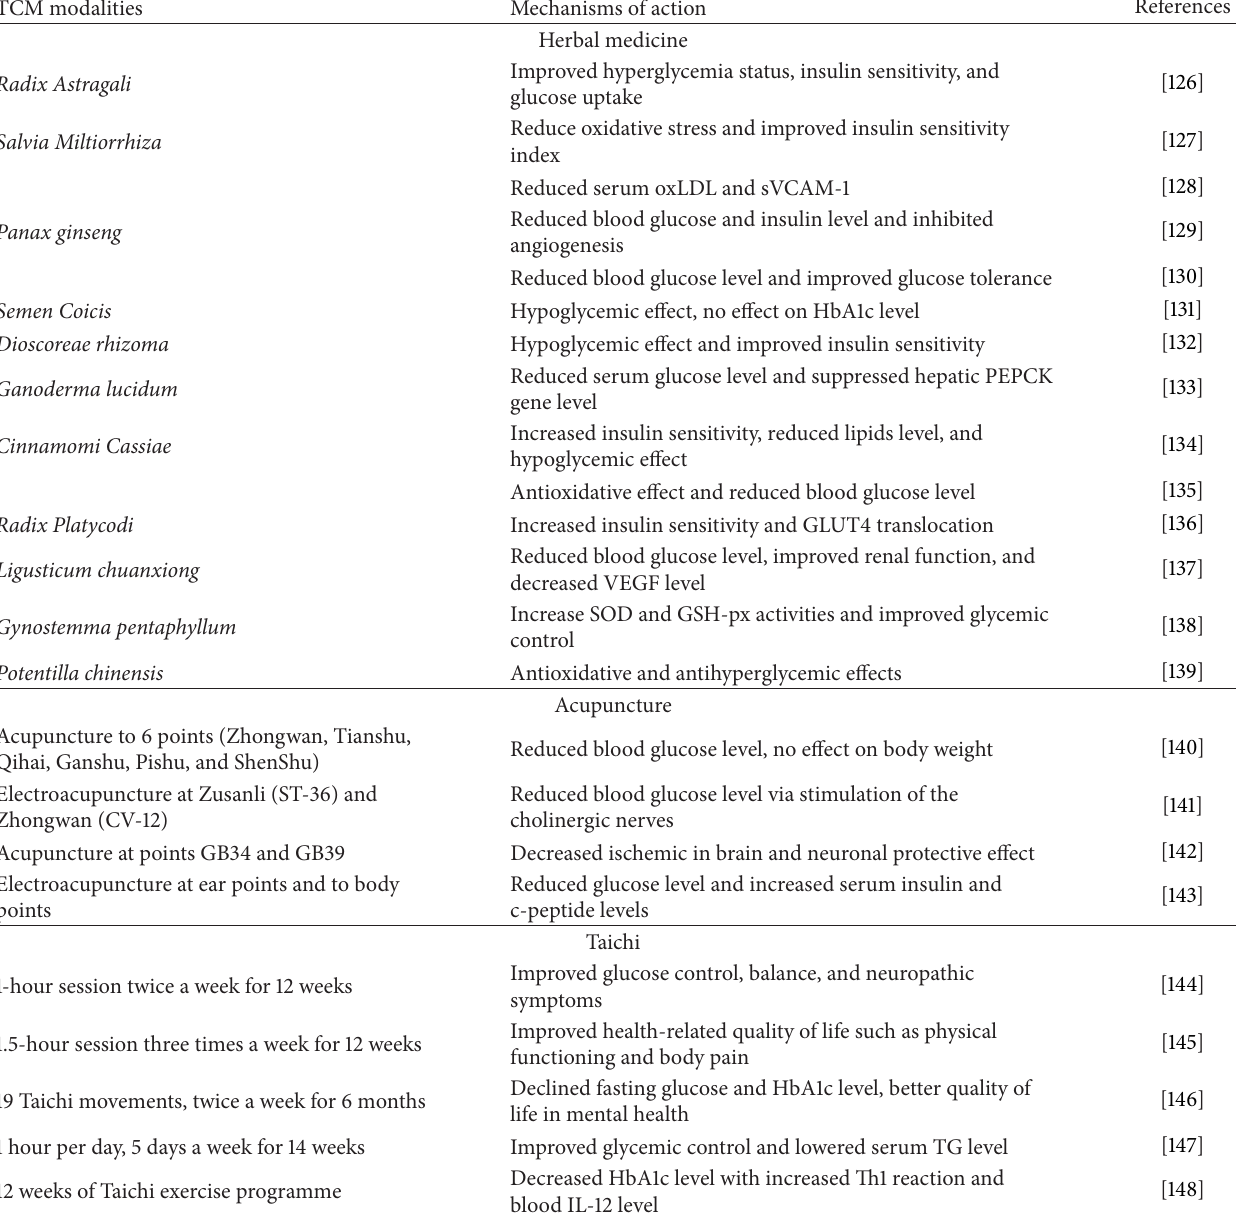
Table 1: A summary of key TCM modalities used of the treatment of